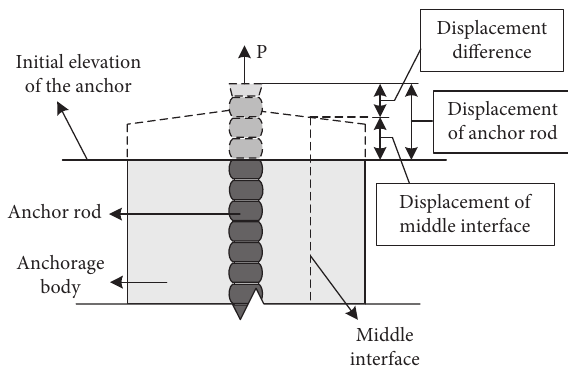
Figure 23: Schematic diagram for the displacements of the anchor rod and anchorage body.